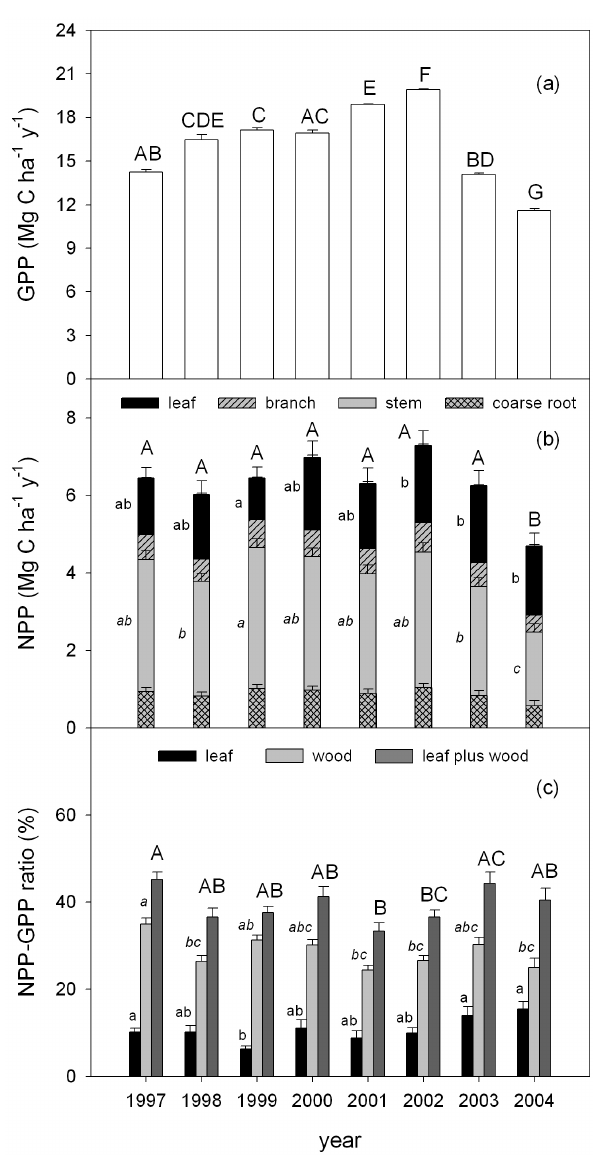
Fig. 4. Annual means of (a) gross primary production (GPP), (b) net primary production (NPP) of leaves, stem, branches and coarse roots, and (c) NPP-GPP ratio of leaves, wood (stem, branches and coarse roots, together) and leaves plus wood, for the study period. Error bars indicate 1SE; in (b) the first horizontal cap at the top of the columns indicates SE of leaves, whereas the second horizontal cap indicates the SE of leaves plus wood. The annual value of each measured variable (GPP, NPP, NPP-GPP) is associated to a letter (or to a combination of letters) for each experimental year: lower case letters refer to leaves, lower case italics to wood and capital letters to leaves plus wood. For each organ and measured variable, lack of the same letter between years indicate a significant differ- ence ( p < 0 . 05), whereas the presence of the same letter indicate lack of significant